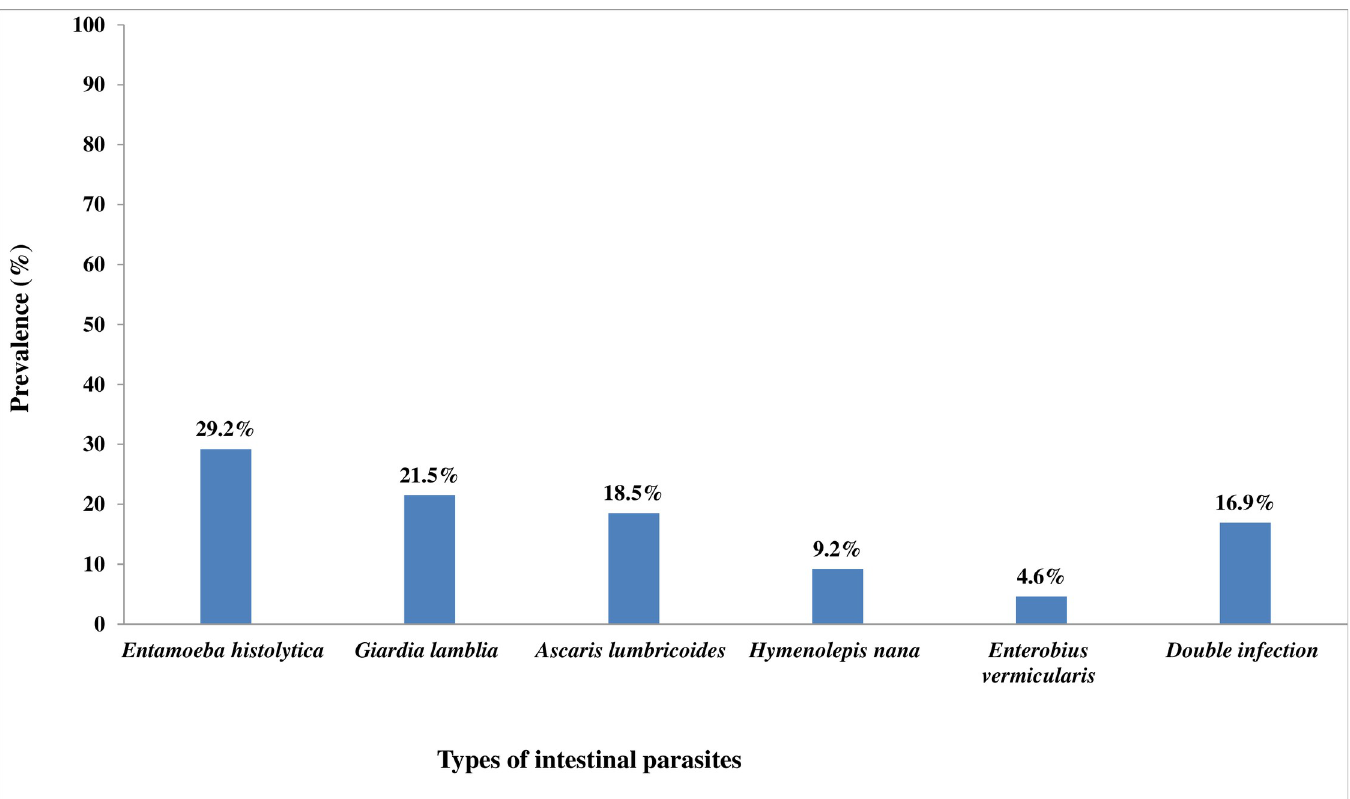
Fig 2. Types of intestinal parasitosis among Grades 4–8 primary school children in Dessie City, Ethiopia, April to June 2018.